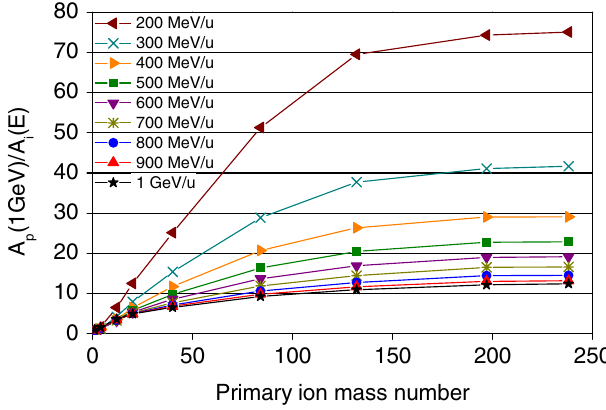
FIG. 7. (Color) Scaling factor for the beam-loss tolerance as a function of primary-ion mass. The scaling factor is represented by the ratio of the normalized activity induced by 1 GeV proton ð 1 GeV Þ , to the normalized activity induced by the beam, A p ð E Þ . The activities were beam of interest at given energy, A i calculated by FLUKA at the end of irradiation. The relative standard uncertainty of the presented data is less than 0.76%.